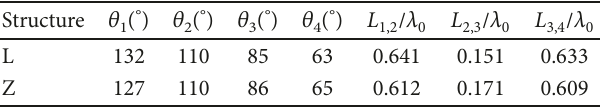
Figure 5: A unit cell of the proposed 4-layered perfect LP converters, (a) top view of L , (b) top view of Z , (c) 3D view of L , and (d) 3D view of Z con fi gurations. Table 1: Design parameters of the proposed 4-layered perfect LP converters.